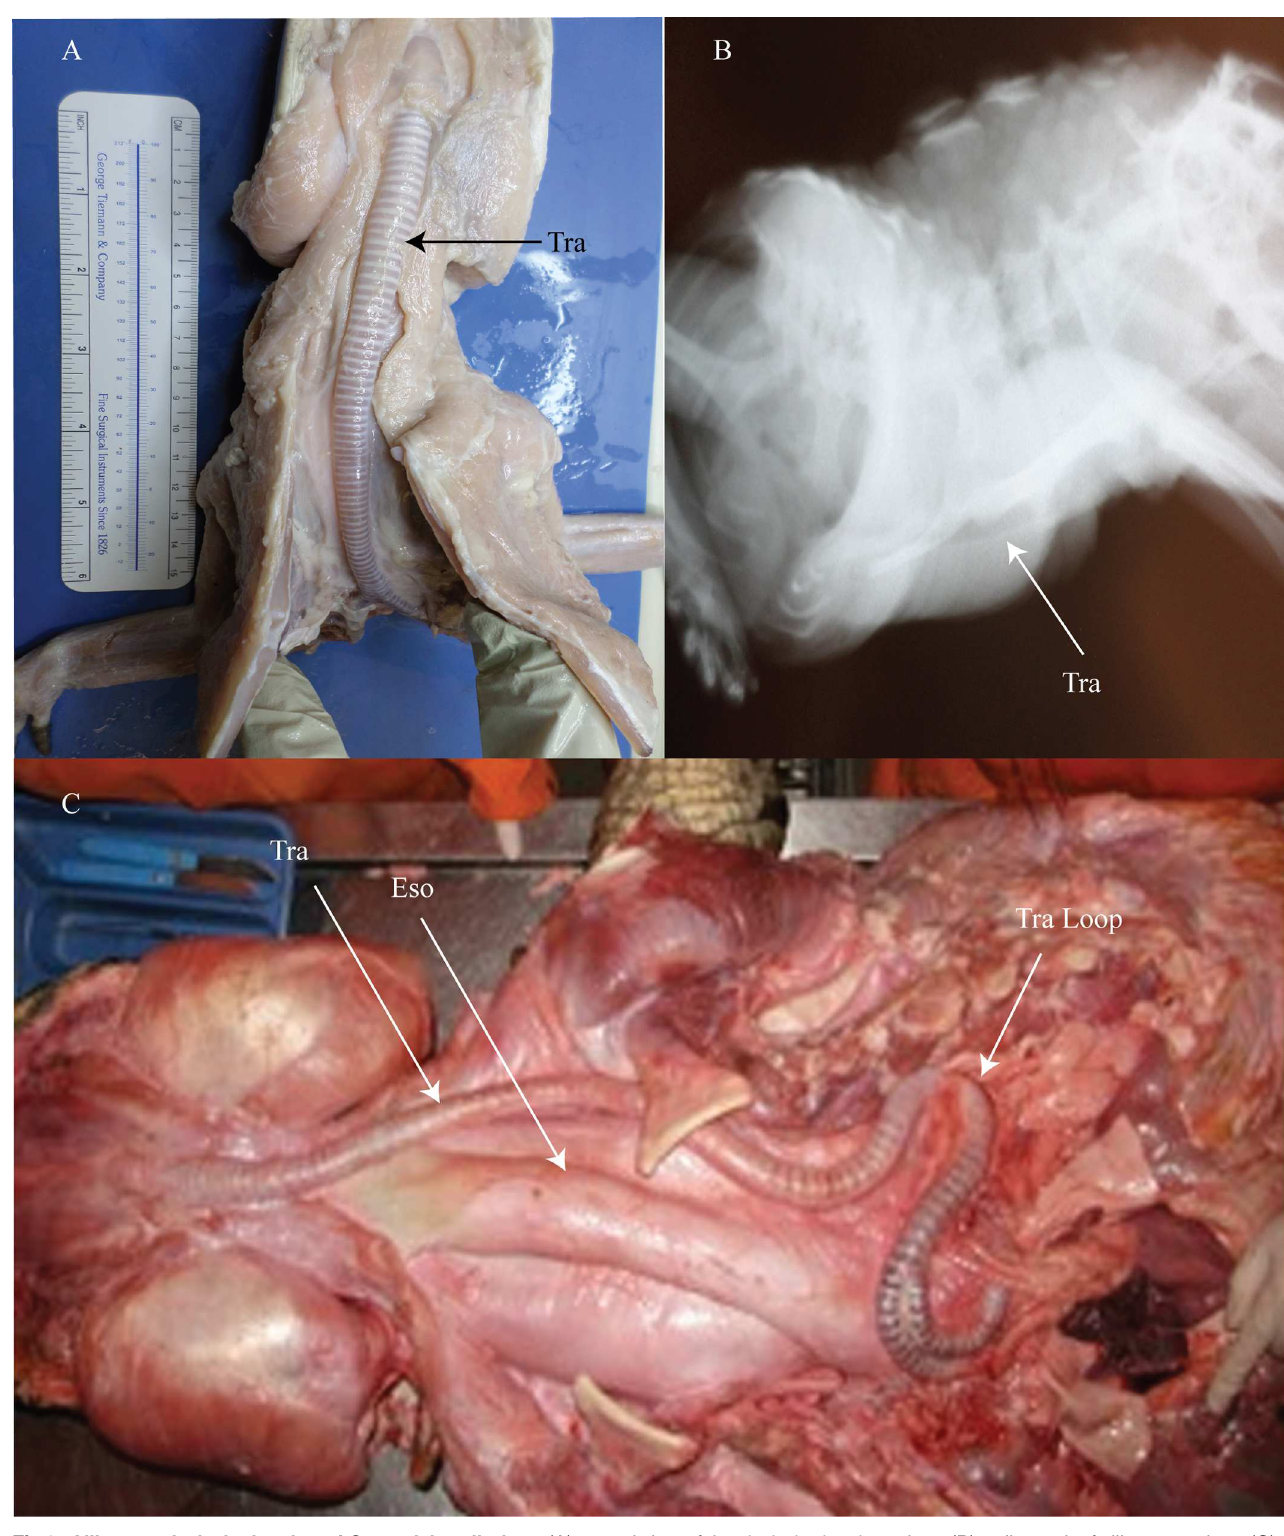
Fig 2. Alligator mississippiensis and Crocodylusniloticus . (A) ventral view of A . mississippiensis trachea.(B) radiograph of alligatortrachea.(C) ventral view of the Nile crocodile’s trachea and esophagealcourse. Tra = trachea;Eso = esophagus; Tra loop = trachealloop. Nile crocodileimage courtesyof J.